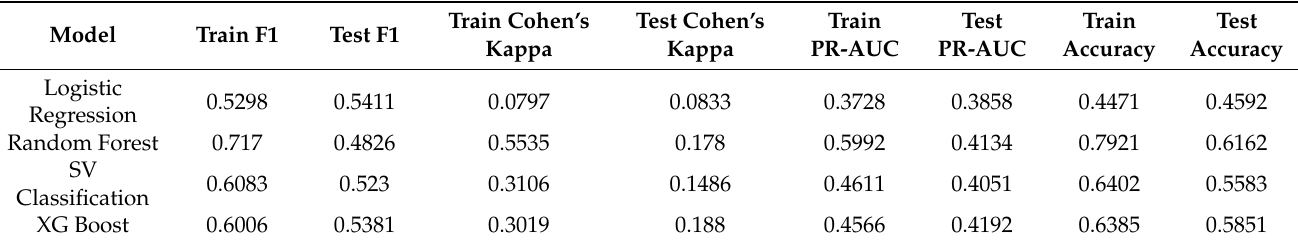
Table 2. Accuracy score for each classification model in predicting stunting.